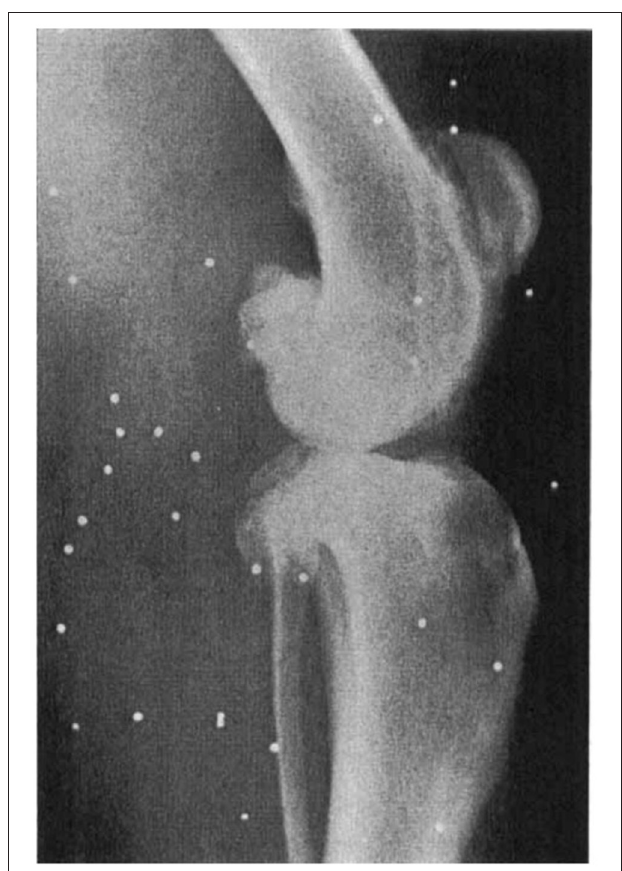
FIGURE 2 | Lateral radiograph of an older clinically-lame dog in the non-weight bearing position, presented by Morgan in 1969. The radiograph shows evidence of periarticular osteophytosis, subchondral sclerosis and joint space narrowing. Morgan JP. Radiological Pathology and Diagnosis of Degenerative Joint Disease in the Stifle Joint of the Dog. J Small Anim Pract. 1969; 10:541–4. Reprinted with permission.